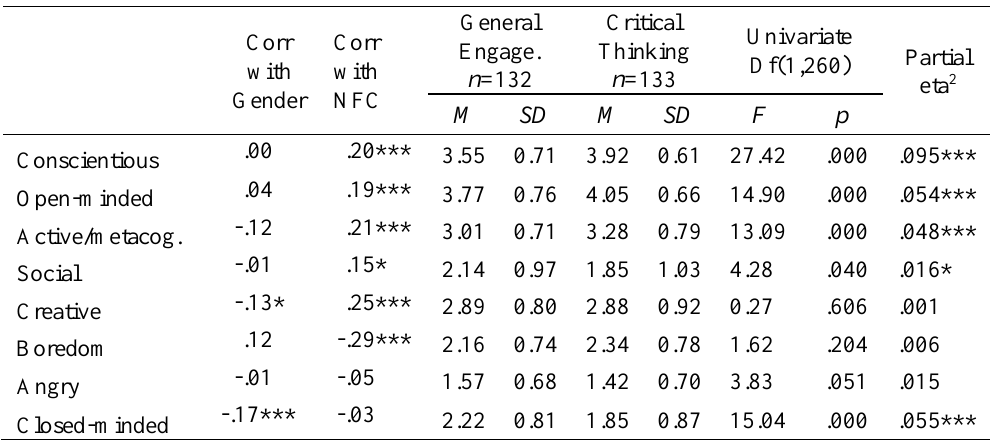
Study 2 univariate follow-ups examining engagement states during T2